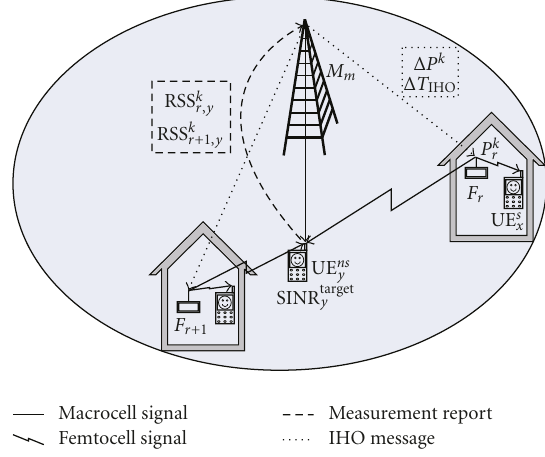
Figure 2: Power control algorithm for